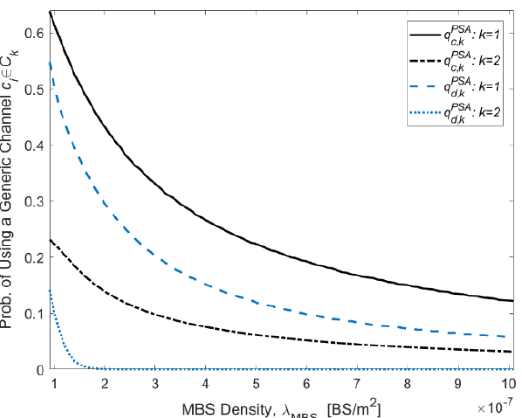
Figure 11. The 𝑞 𝑐,𝑘PSA and 𝑞 𝑑,𝑘PSA in the underlay in-band D2D mode vs. the density of MBSs when the PSA policy is used.